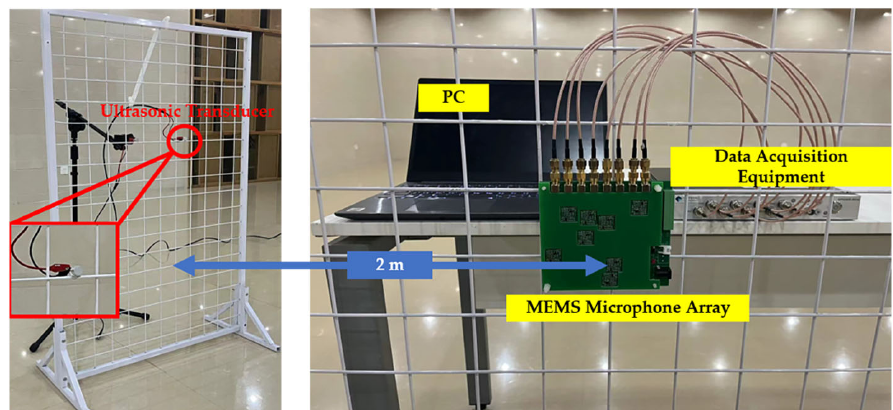
Figure 7. The setup of acoustic source localization experiment. The acoustic wave is produced by an ultrasonic transducer shown in the left picture. The data acquisition system is shown on the right side of the figure.